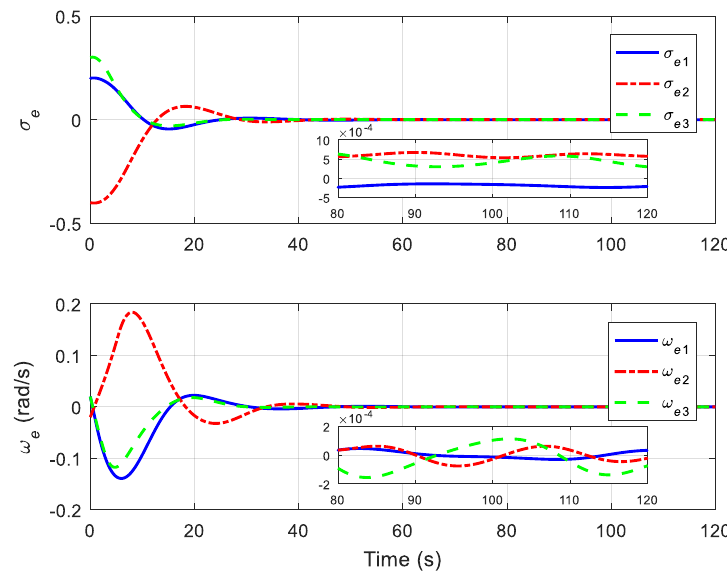
Figure 8. Relative attitude and angular velocity under the PD controller.